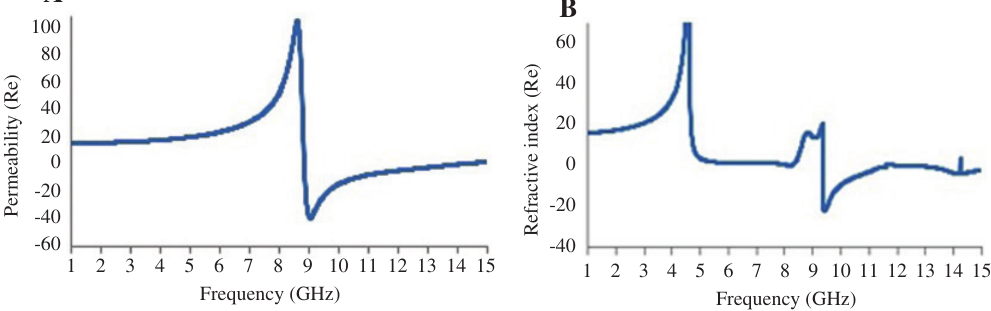
Figure 4: (A) Real value of effective permeability versus frequency and (B) real value of refractive index ( η ) versus frequency for z -axis wave propagation.